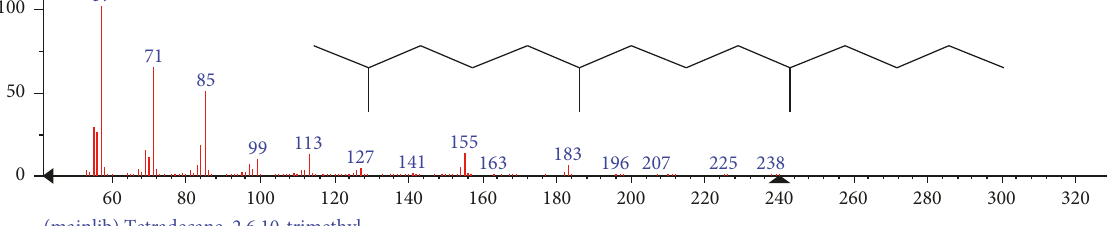
Figure 48: Mass spectrum of compound tetradecane, 2,6,10-trimethyl- of whole plant hexane fraction of Achillea wilhelmsii (WHFAW).